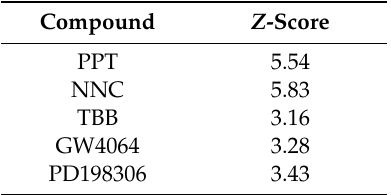
Table 2. Z-scores of C. elegans screening